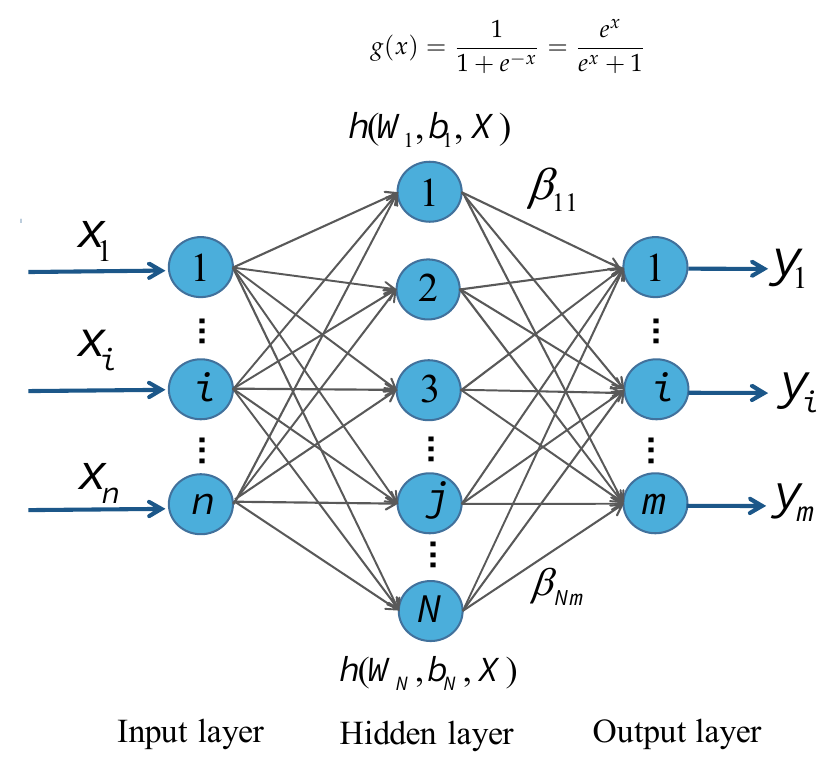
Figure 1. Network structure of the extreme learning machine.